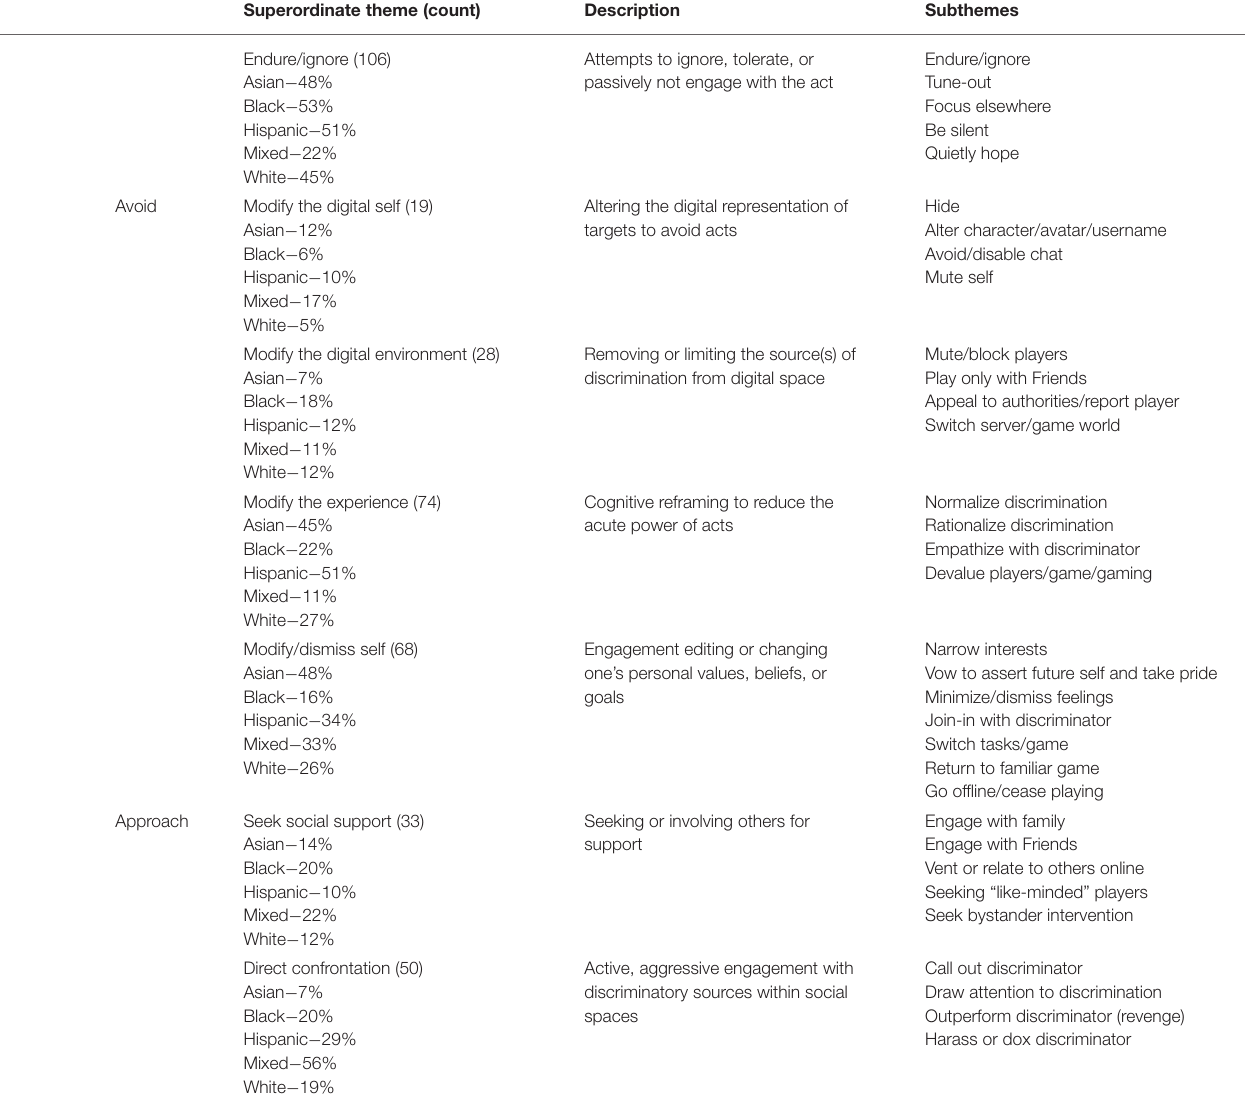
TABLE 2 | Seven superordinate themes for strategies for coping organized by avoid to approach (top to